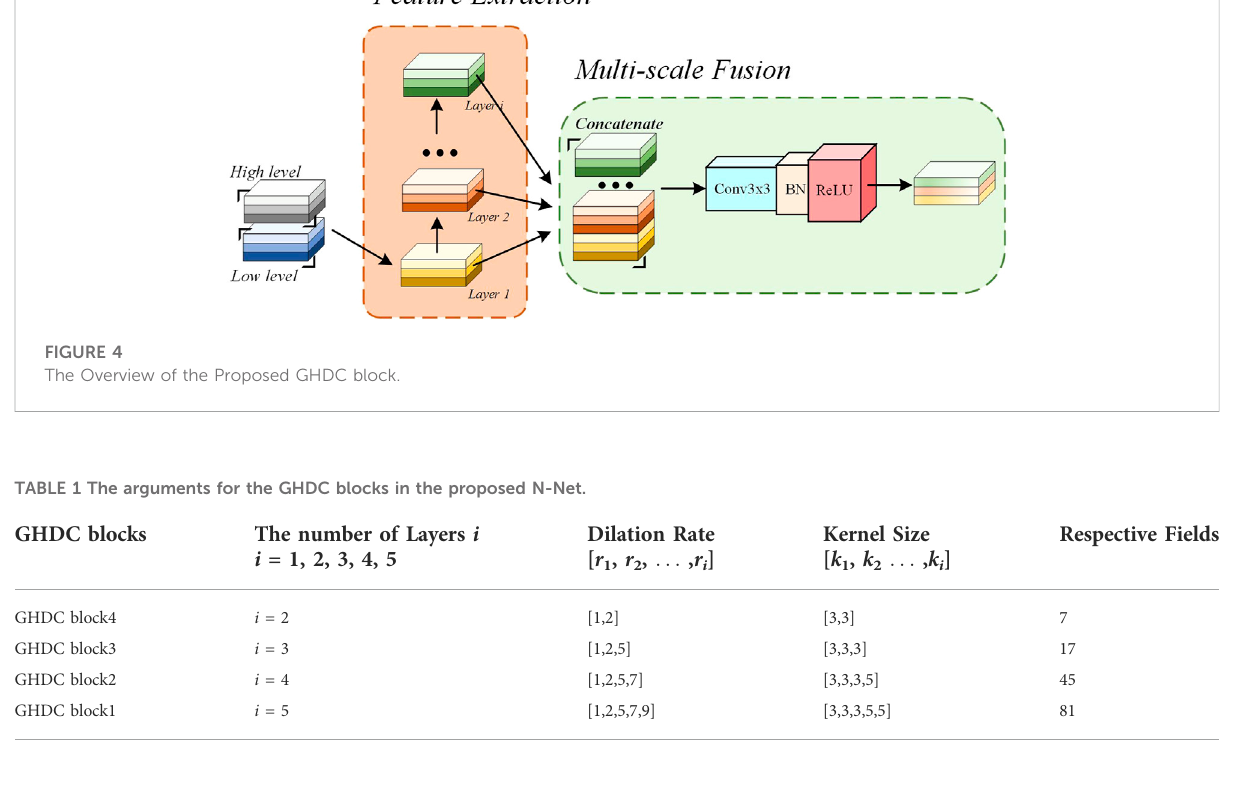
Dilation Rate Kernel Size [ r 1 , r 2 , ... , r i ] [ k 1 , k 2 .. . , k i